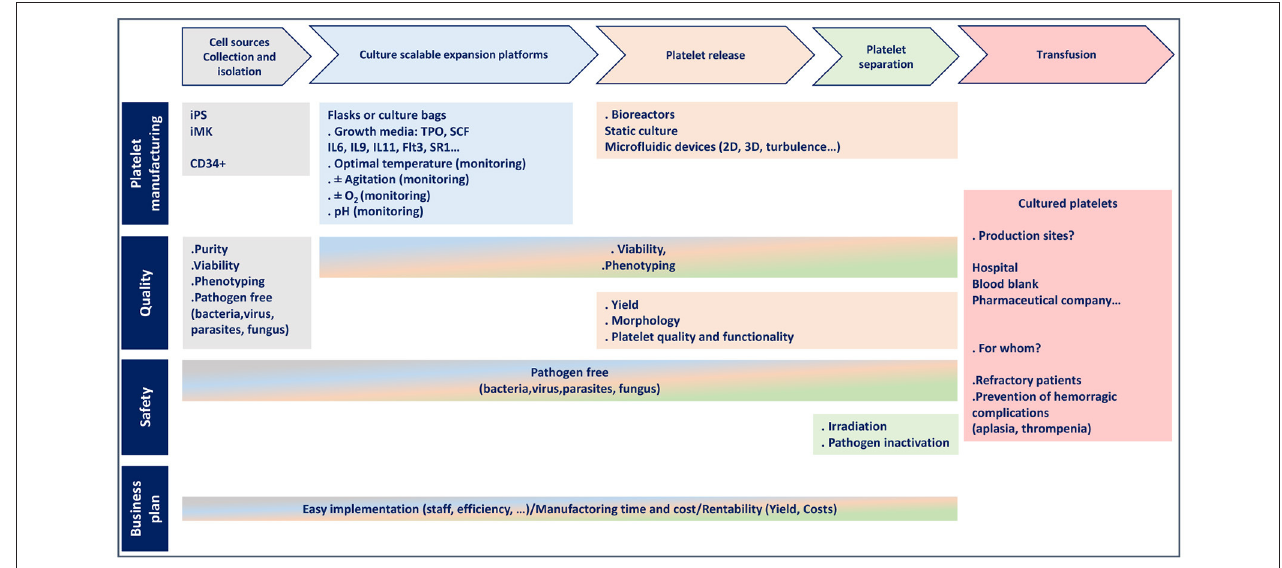
FIGURE 2 | Flowchart for platelet